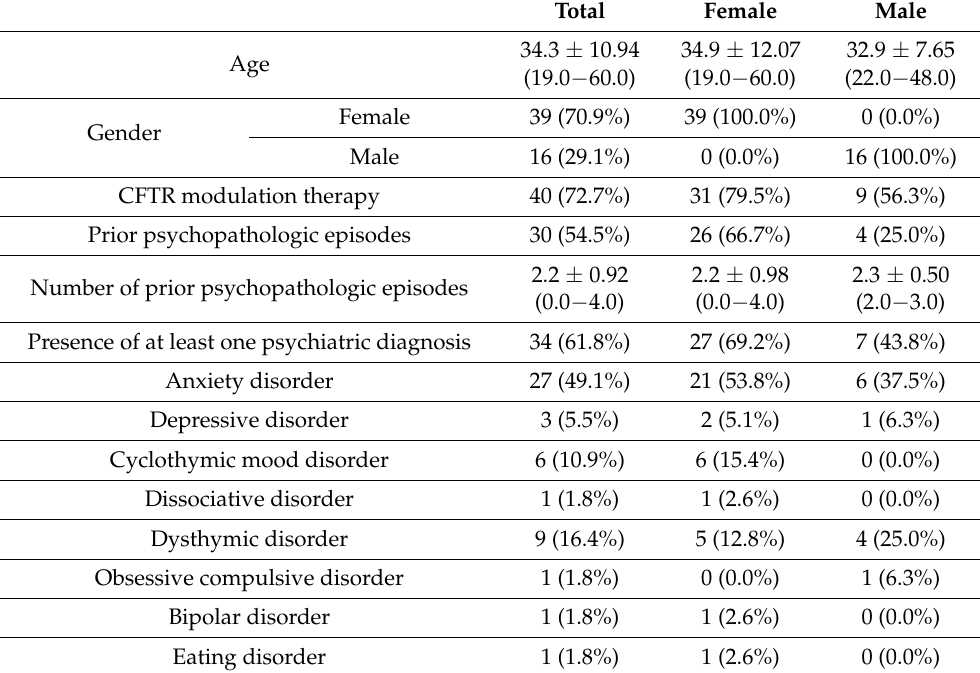
Table 1. Demographic and clinical–anamnestic data (N =